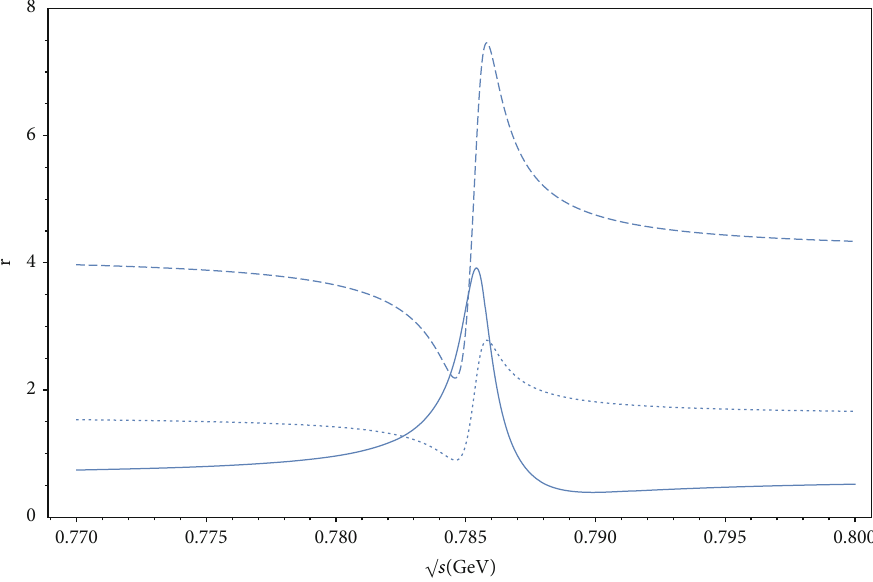
ffiffi p corresponding to central parameter values of CKM matrix elements for s